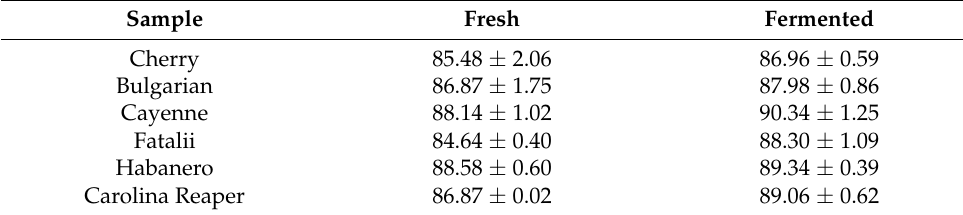
Table 2. Average humidity of fresh and fermented pepper samples